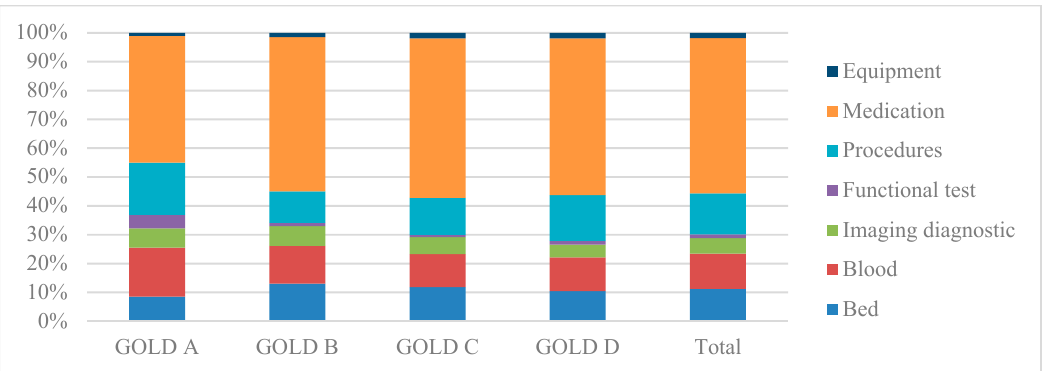
Figure 1. Distribution of cost components according to disease stages.